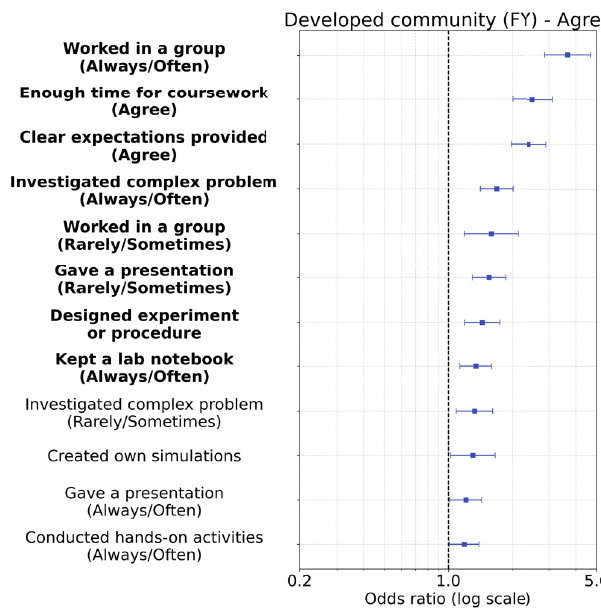
FIG. 10. Logistic regression odds ratios for students who agreed or strongly agreed that they developed a sense of community compared with all other students. Only variables with uncorrected p values less than 0.05 are shown. Bold variables are those that are statistically significant after the Holm-Bonferroni correction. Error bars show 95% confidence intervals. The odds ratios are on a log scale to make the positive and negative effects be of approximately equal